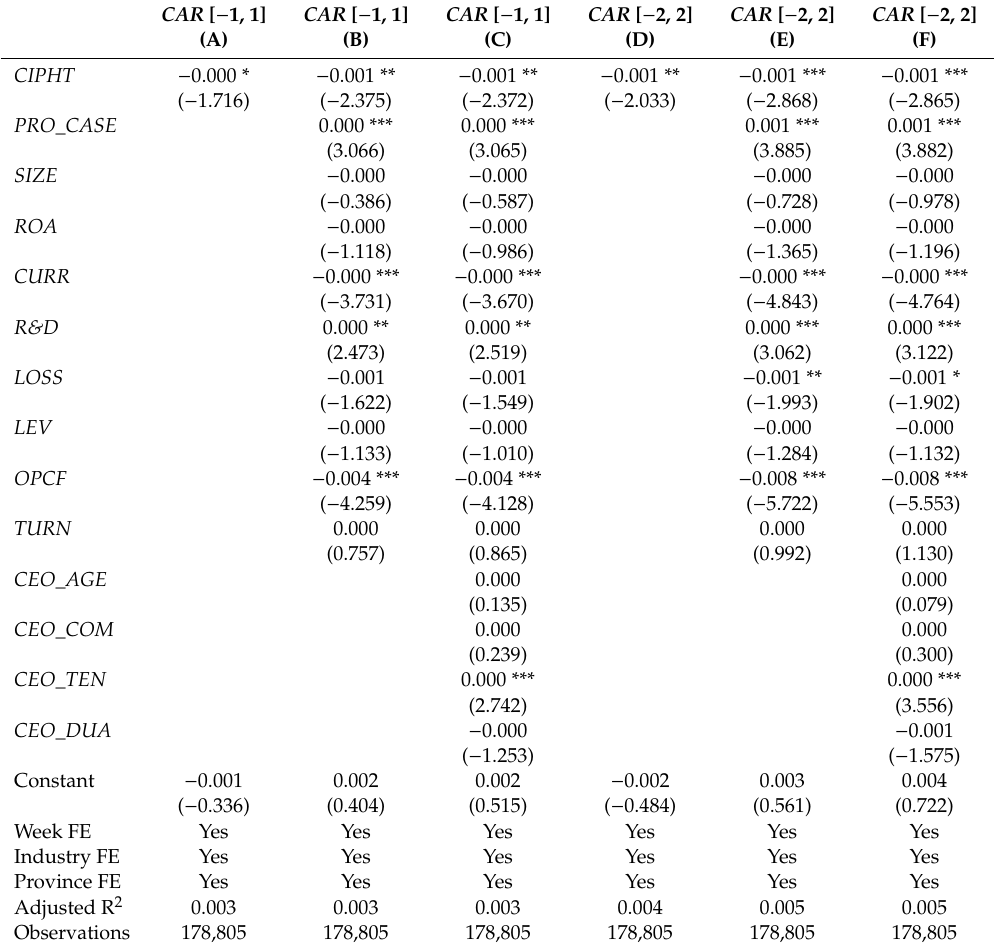
Table 4. Continued increasing public health threats and accumulative abnormal